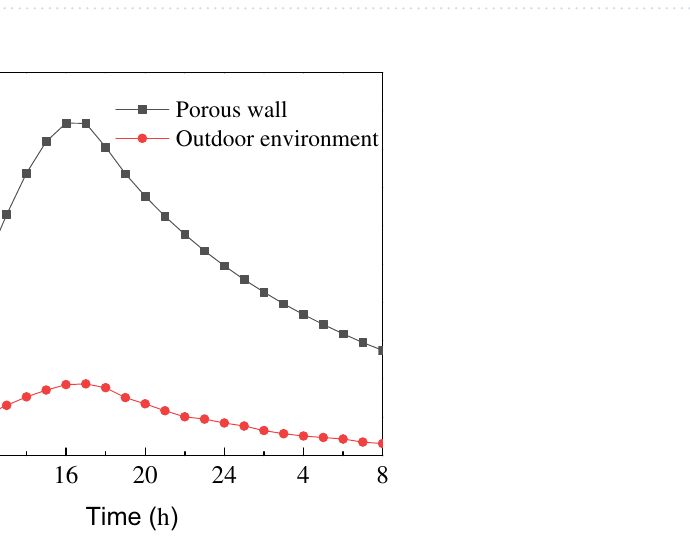
Figure 7. The temperature change of porous wall with